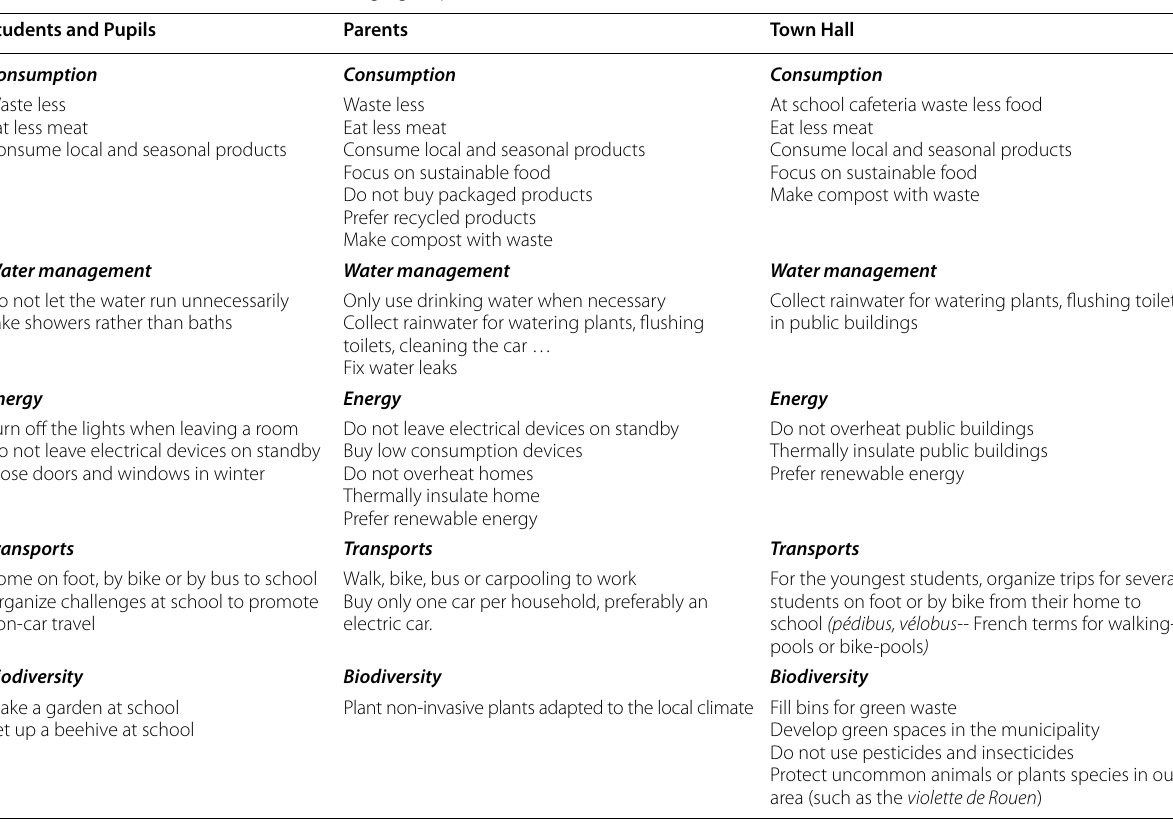
Table 3 The co-created list from the two age groups Students and